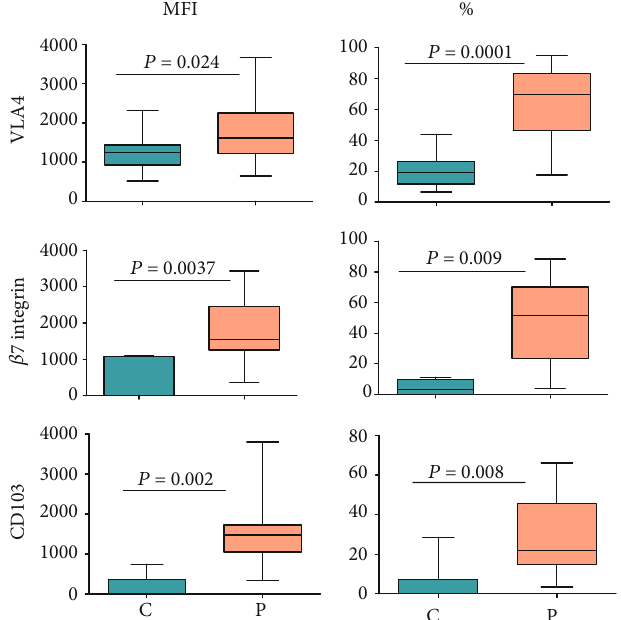
Figure 5: Expression of di ff erent integrins on CD56 bright/dim NK cells in CD patients and healthy controls. The fi gure shows MFI and percentages of NK cells expressing indicated integrins. Each box and whisker plot indicates median, interquartile ranges, and p values for 15 treatment-naïve CD patients and 20 healthy control donors.